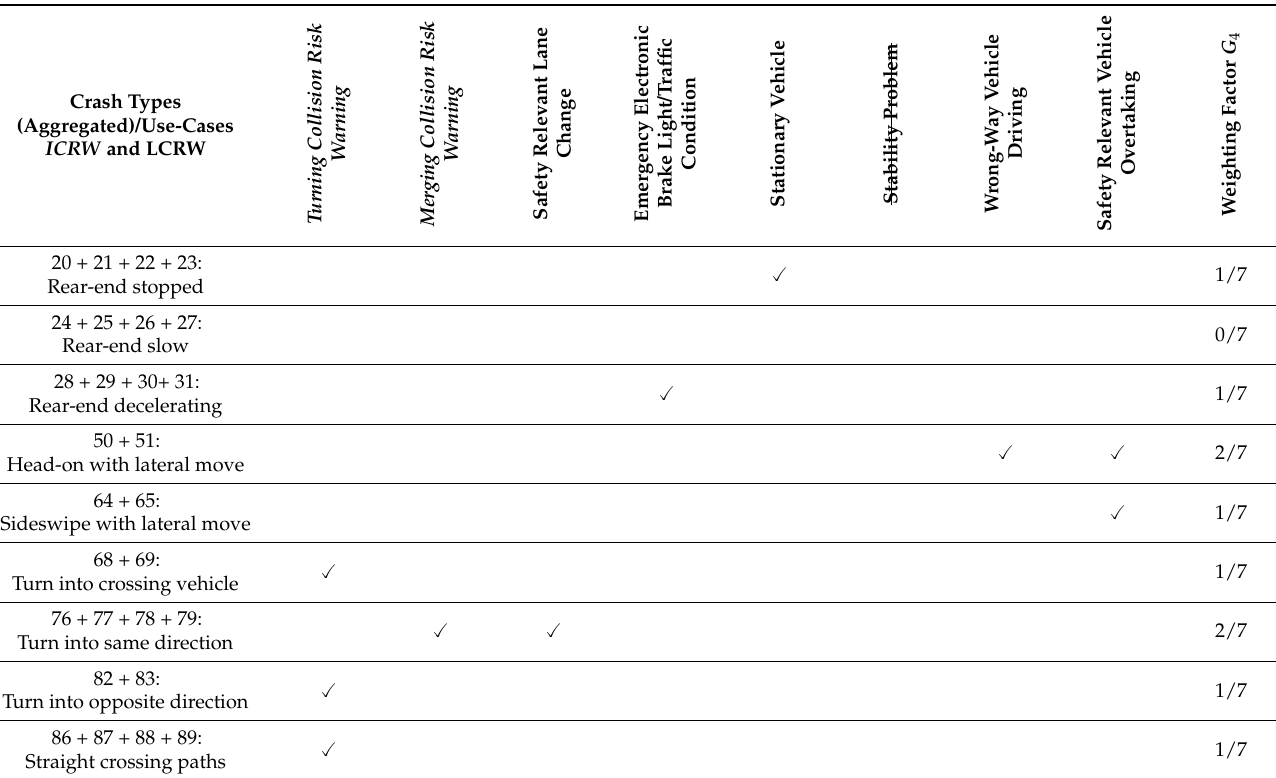
Table 5. Applicability of the V2V use-cases of ICRW and LCRW to the scenarios under investigation and calculation of the weighting factor